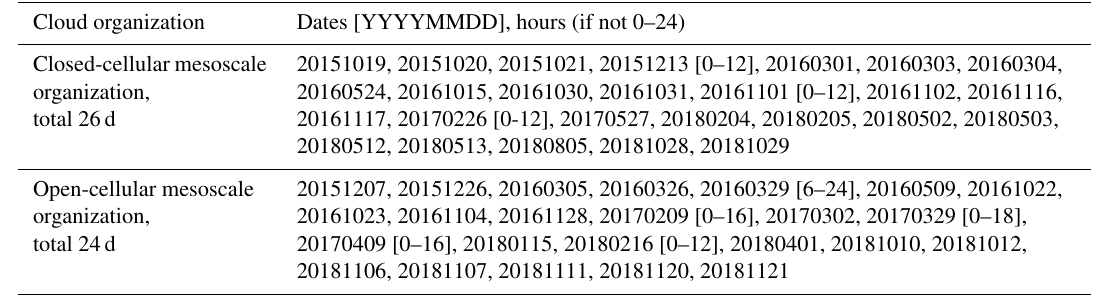
Table 1. List of days and hours if not the whole day, with closed- and open-cellular mesoscale organization at the ARM ENA site.